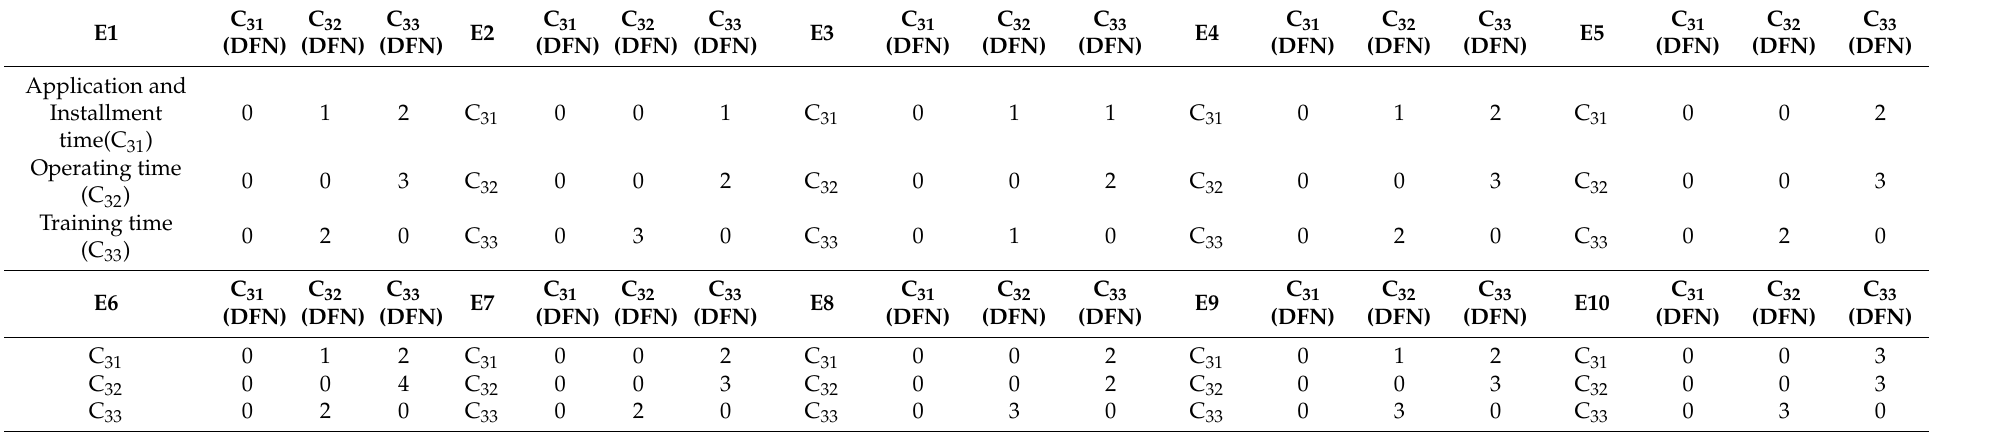
Table A4. Degree of direct fuzzy influence between Time (C 3 ) sub-criterions.